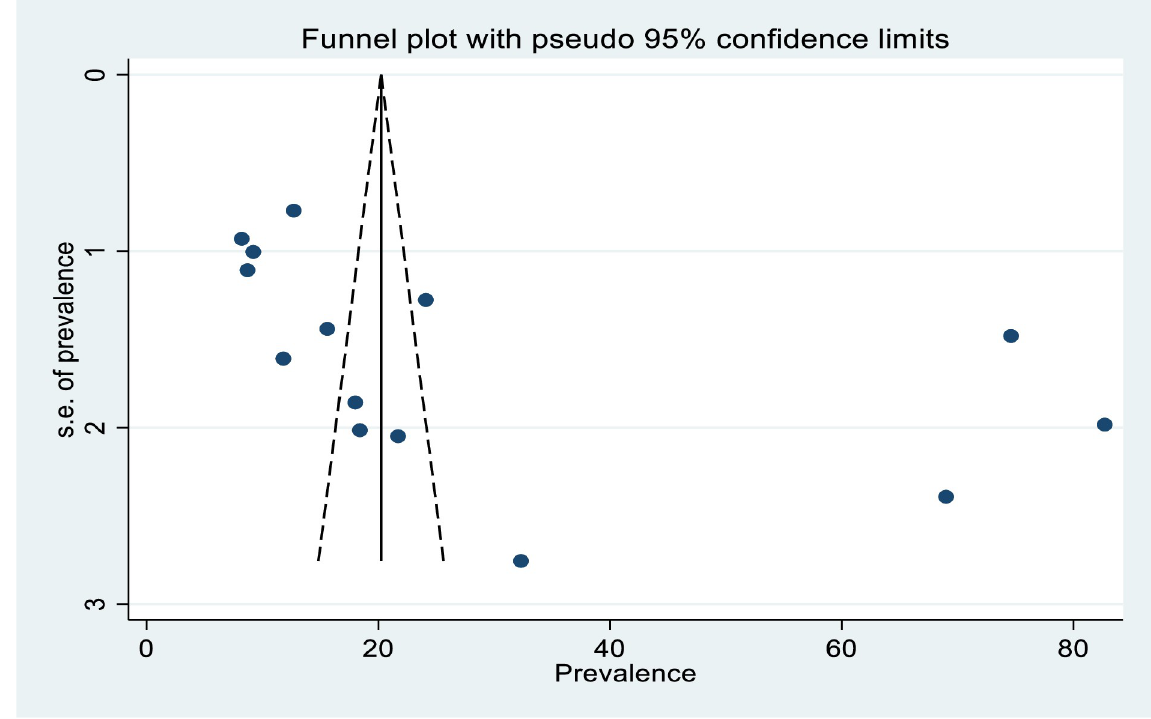
Fig 7. The contour _enhanced funnel